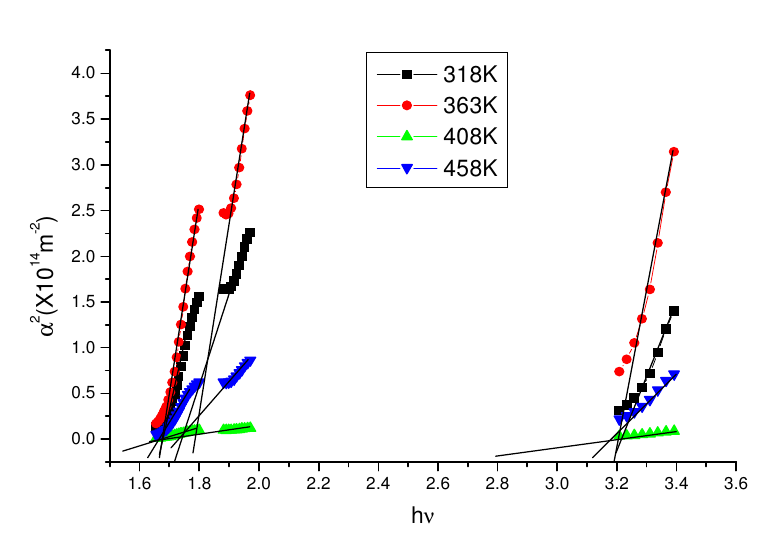
Figure 2. The plot of a 2 vs h n for NiPc thin films deposited at substrate temperatures 318, 363, 408 and 458K is given in the.